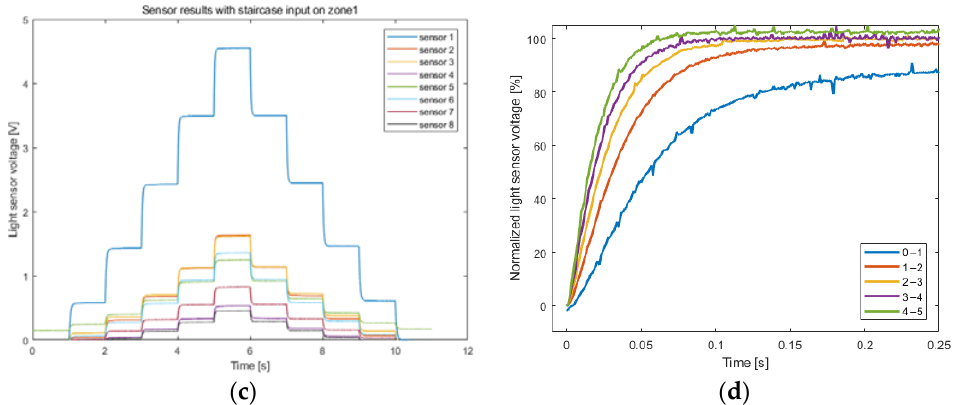
Figure 3. System characteristics after calibration: ( a ) static characteristic of zone 1 after calibration; ( b ) staircase experiment input signal; ( c ) staircase experiment data for each zone with the input is given in zone 1; ( d ) normalized staircase of zone 1 after calibration.